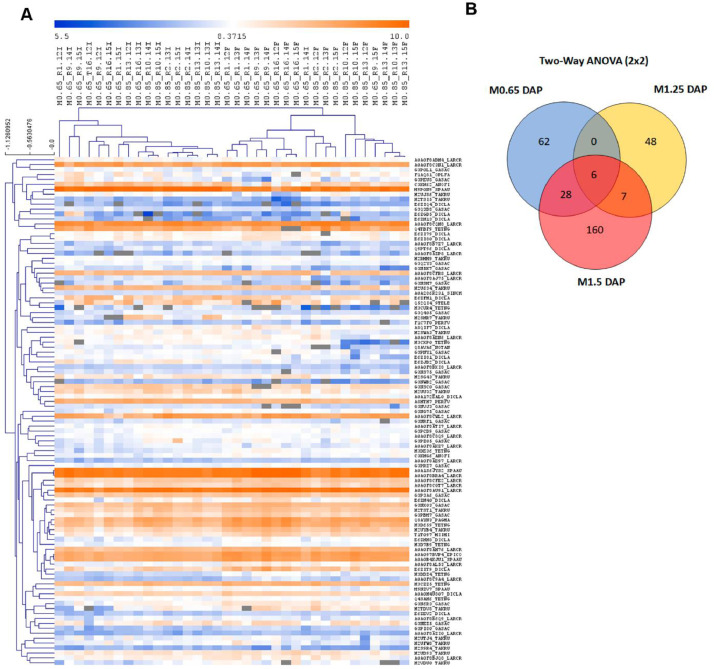
Proteins with significant differential abundance (Two-way ANOVA, p < 0.05) between fish fed with experimental diets in respect to the reference diet (M0.85), across two sampling time points i.e., 18 and 85 days of feeding. A) an example is provided for fish fed with M0.65 diet compared with M.0.85. B) Venn diagrams indicate the number of DAP in all pairwise comparisons between fish fed with the distinct experimental diets, across the two sampling time points.